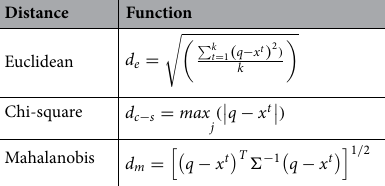
Table 4. Distance functions for k -NN